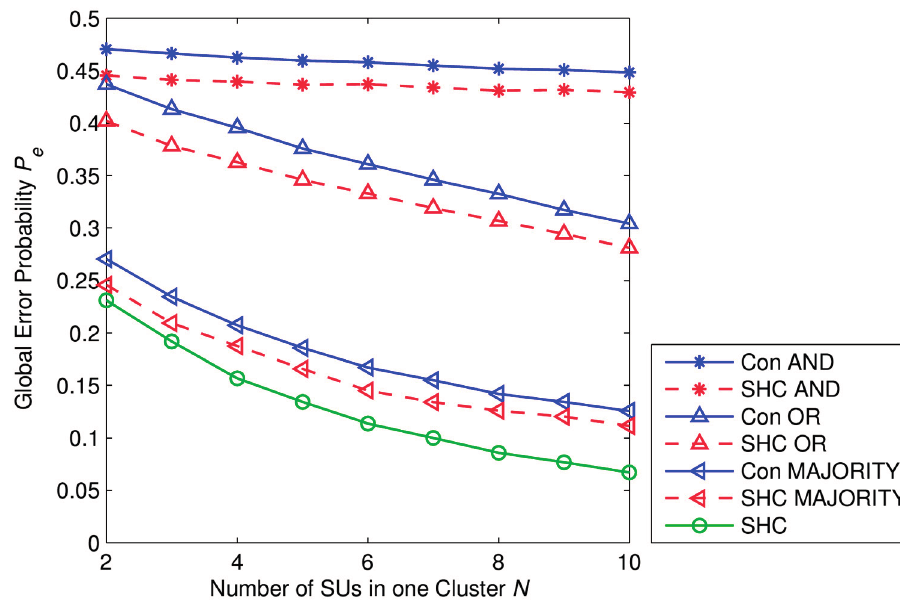
Figure 9. Global error probability P e as a function of number of SUs in one cluster, with P 1 = P 0 = 0.5, M = 50 samples, K = 5 clusters, SNR set = [ − 18 − 16 − 14 − 12 − 10] dB